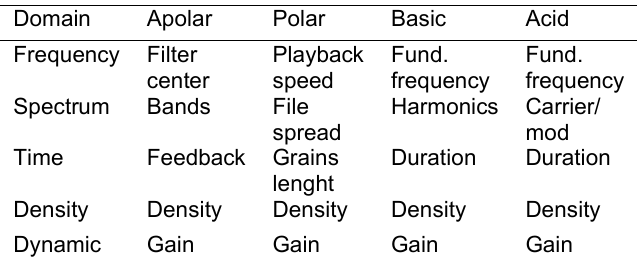
Table 2. Parameter